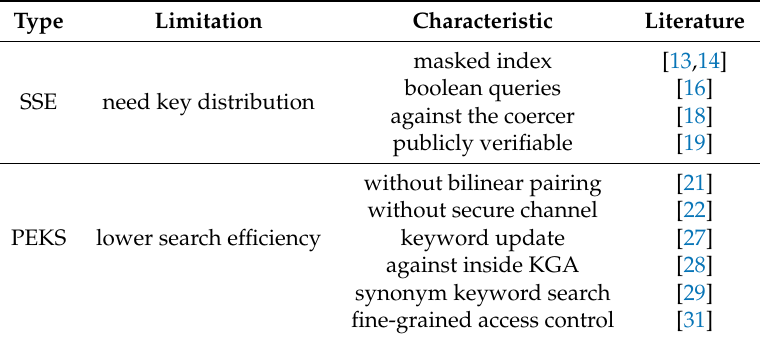
Table 1. A comparison of some existing searchable encryption